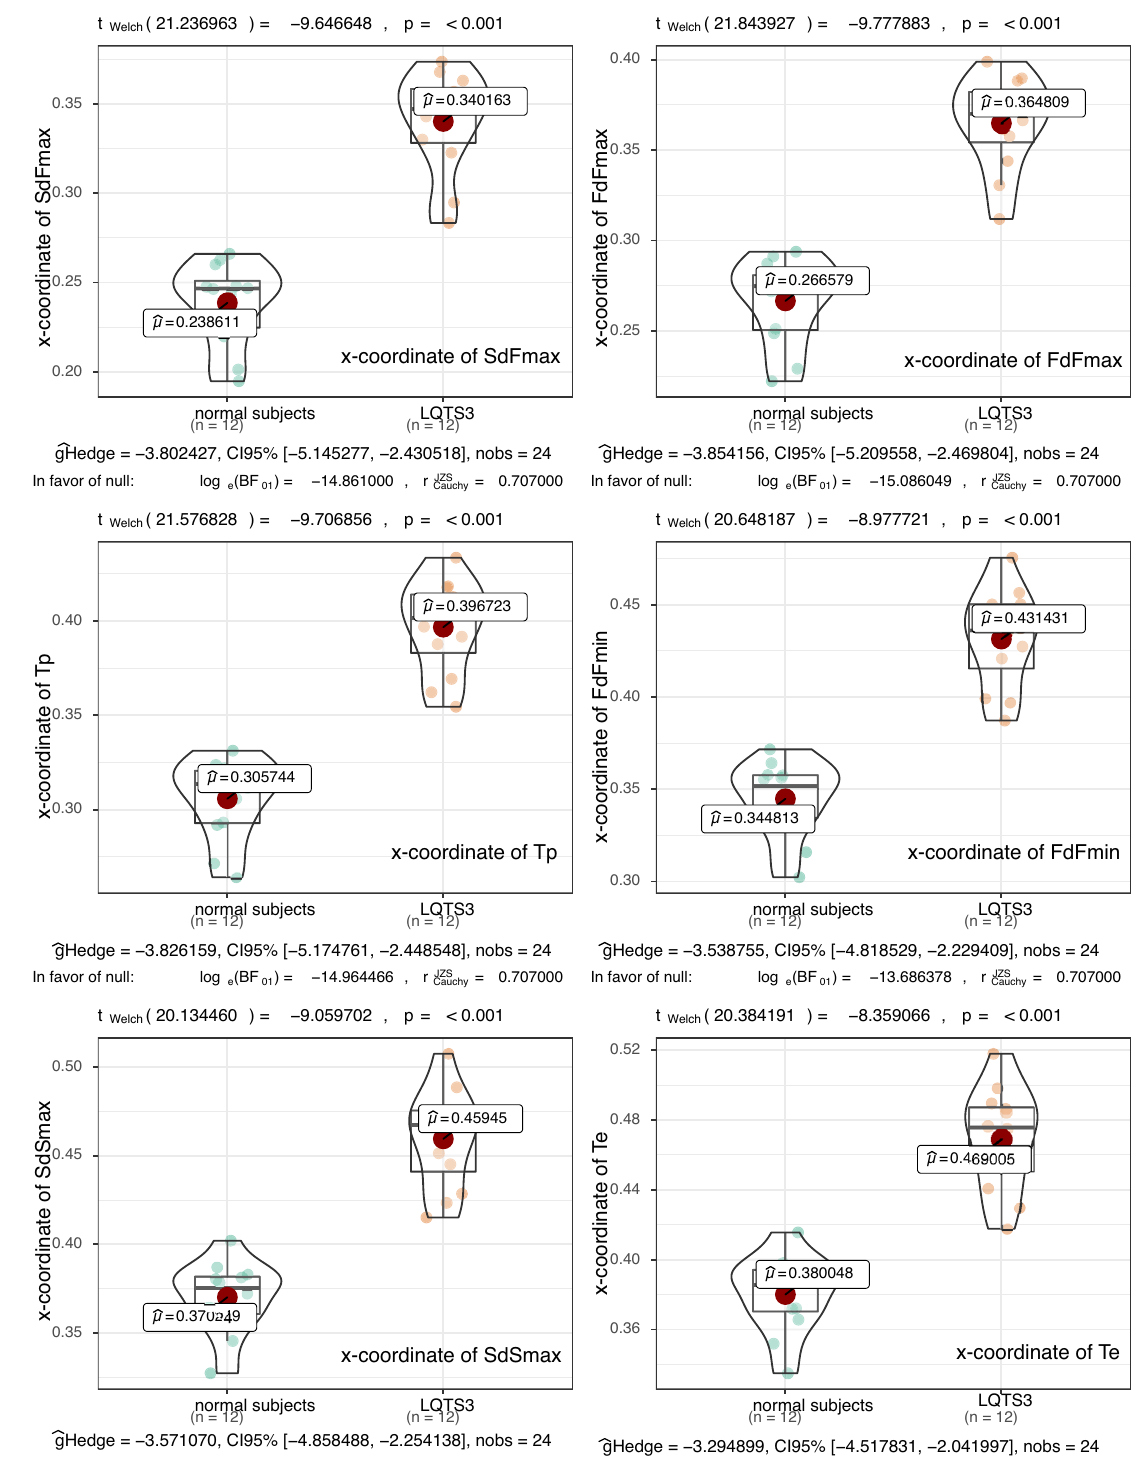
Figure 2. Violin plots for comparing the landmarks of the x-coordinates (SdFmax, FdFmax, Tp, FdFmin, SdSmax and Te) between the normal subjects and the LQTS3 patients. The mean values of the x-coordinate landmarks were greater in the LQTS3 patients than in the normal subjects. The p values of the landmarks of the x-coordinates are less than 0.001. Each Bayes factor shows decisive evidence for rejecting our expected null hypothesis. R version 4.0.2 URL https:// www.R- proje ct.